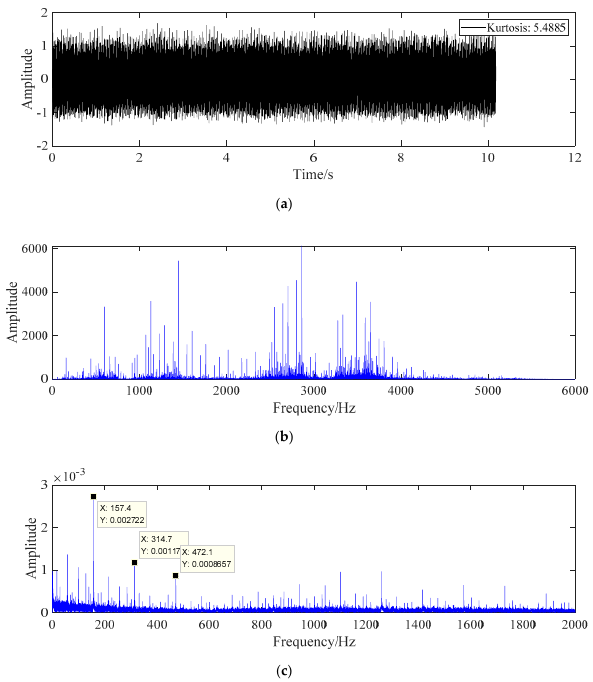
Figure 9. The fault diagnosis diagram of fault data A. ( a ) Time domain diagram of fault data A. ( b ) Frequency domain diagram of fault data A. ( c ) Fault data A whitening energy operator frequency domain graph.